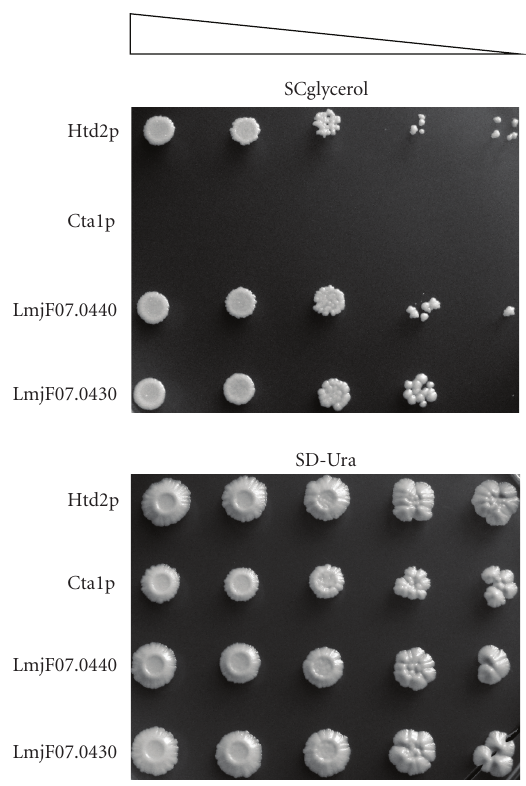
Figure 2: Phenotype rescue of a yeast htd2 Δ strain expressing LmjF07.0440 or LmjF07.0430. Mutant S. cerevisiae BY4741 htd2 Δ cells producing native mitochondrial Htd2p, peroxisomal catalase A Cta1p, or each of the mitochondrially targeted Leishmania proteins LmjF07.0440 and LmjF07.0430 were grown on SD-Ura medium selecting for plasmid presence, and following tenfold serial dilution (triangle), the cells were applied to the indicated solid